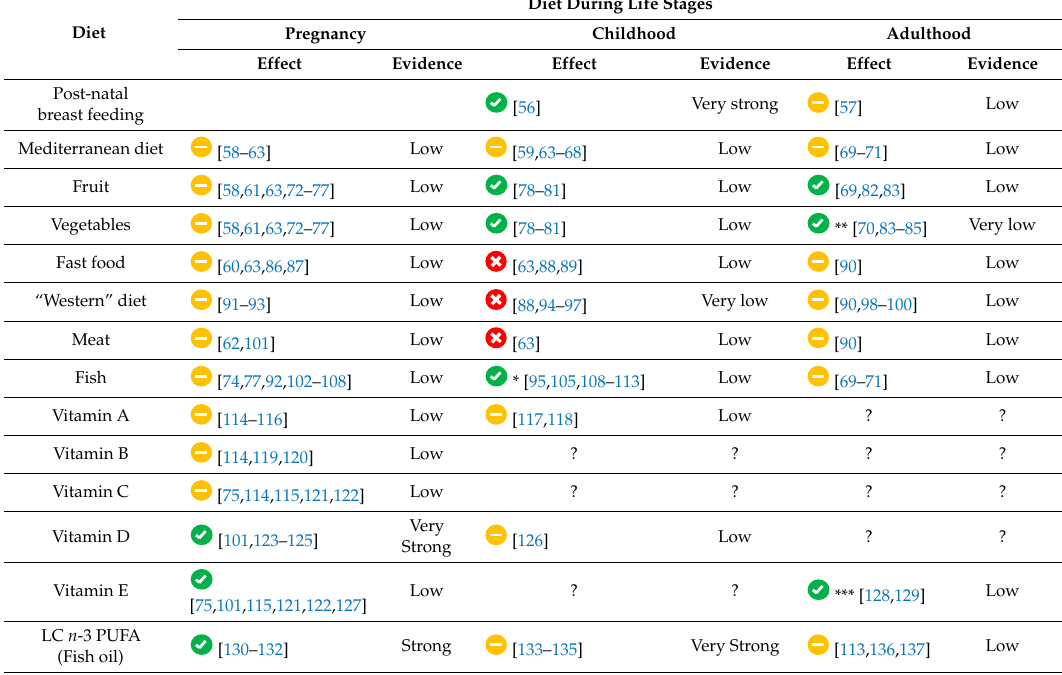
Table 1. Diet and risk of asthma or wheezing. Beneficial effect; negative effect;